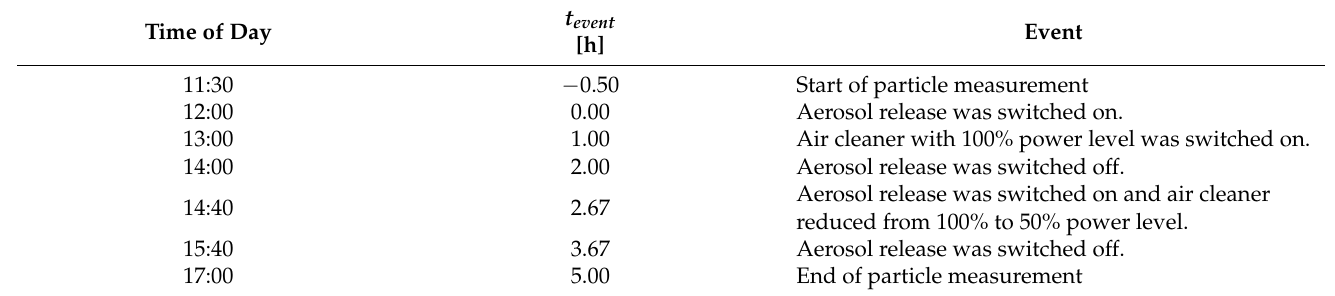
Table 1. Events during determining the clean air delivery rate of an air cleaner in a well-mixed test